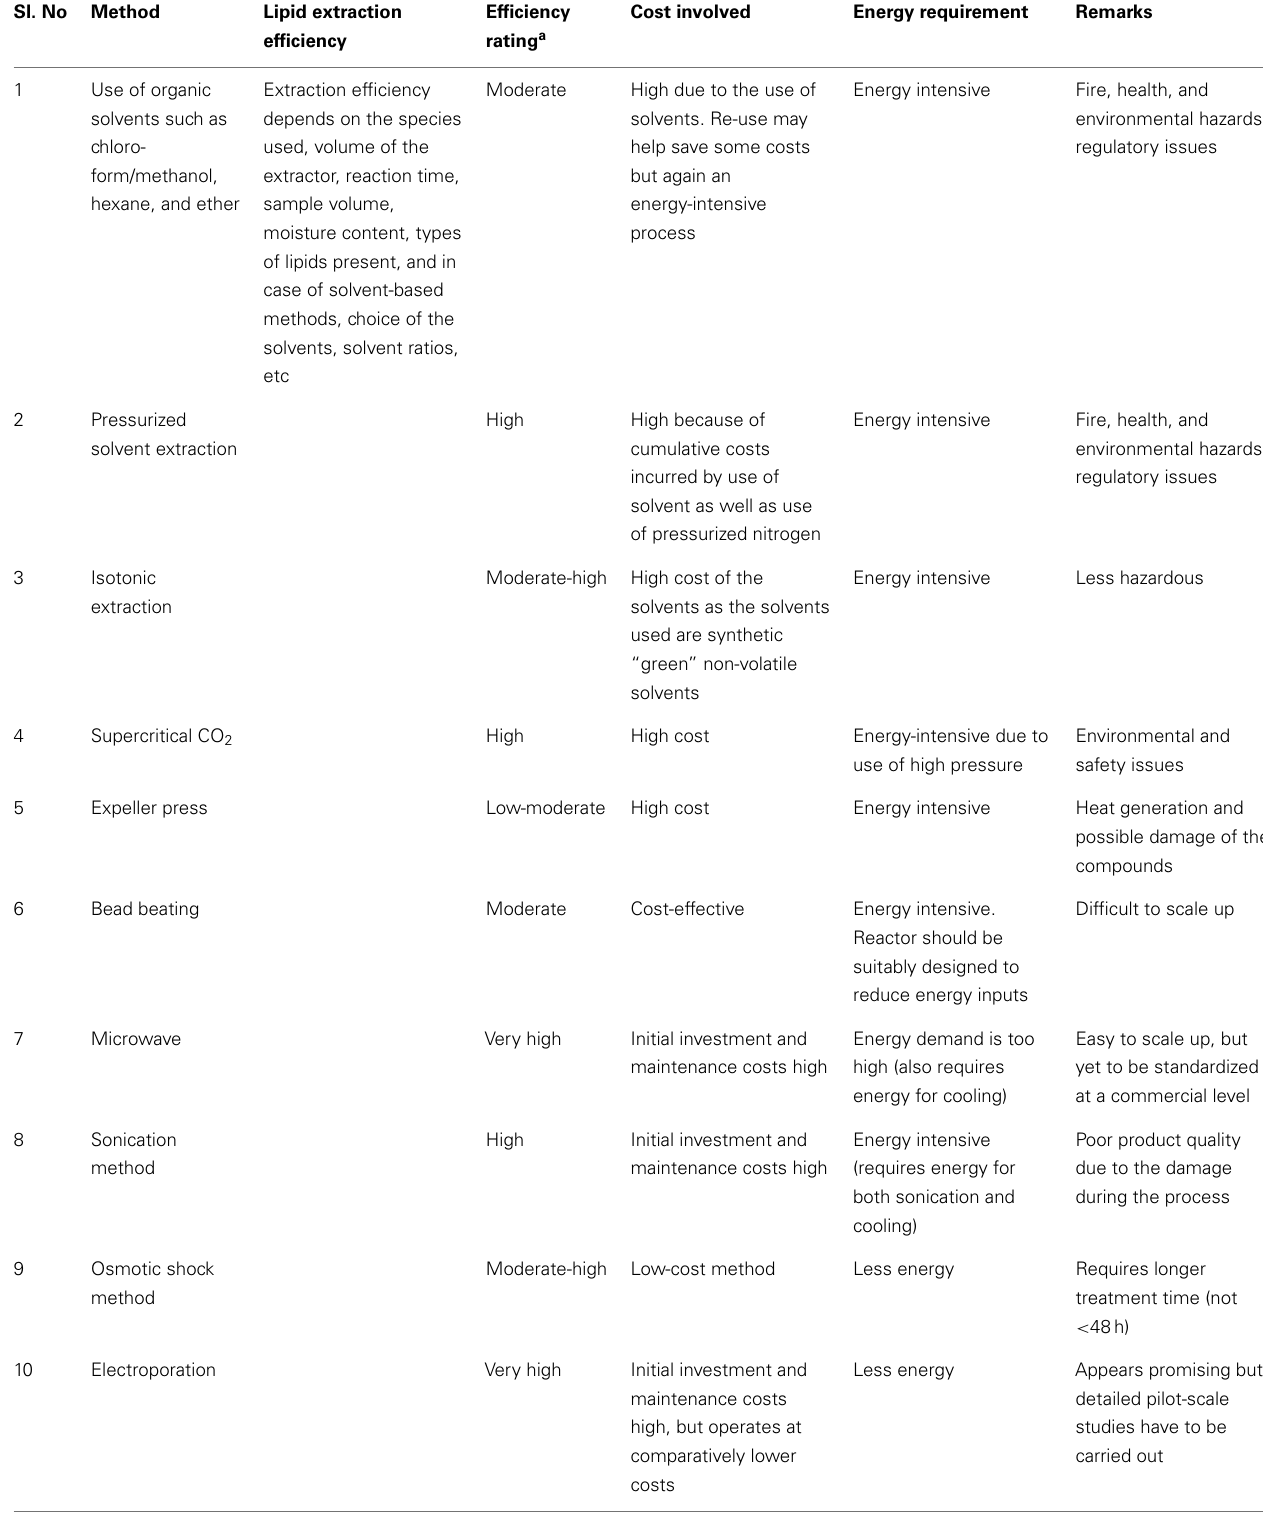
Table 2 | Comparison of different lipid extraction methods: cost and energy efficiency